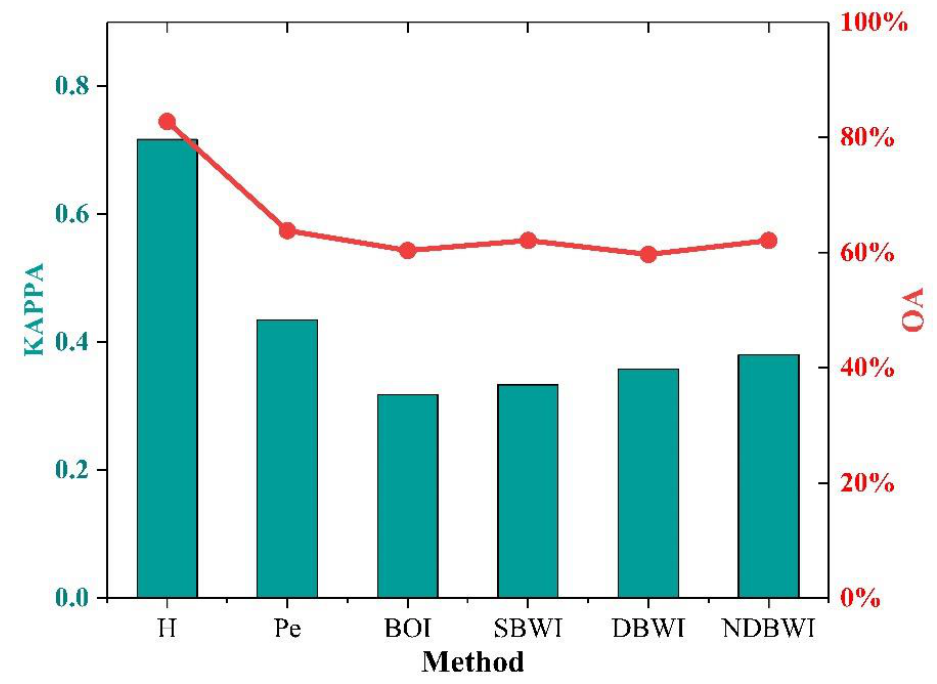
Figure 6. Model accuracy verification by overall accuracy and KAPPA coefficient.